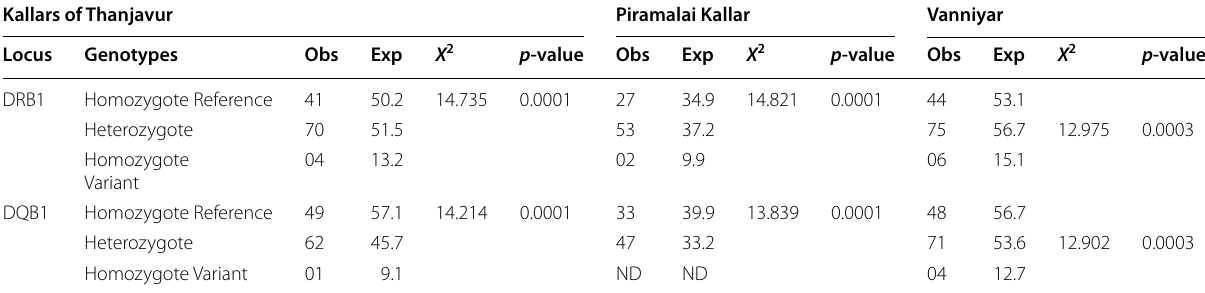
Obs . Observed, Exp . expected, ND not detected